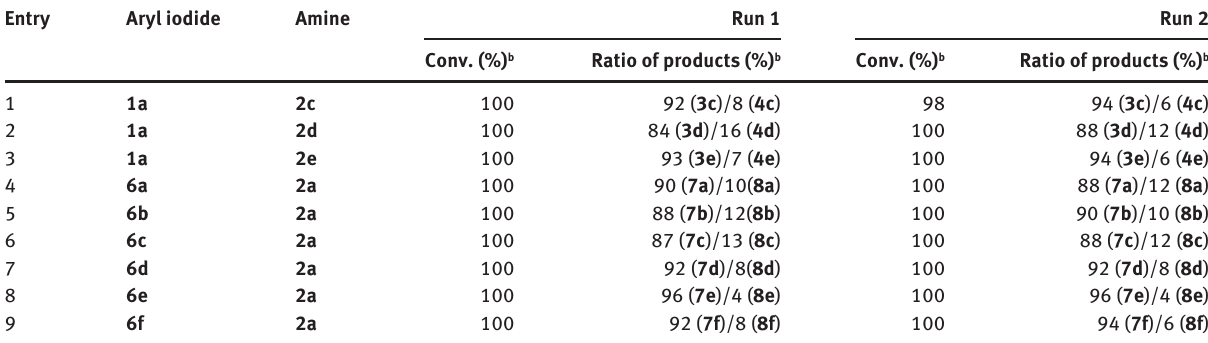
Table 5: Aminocarbonylation of other substrates a